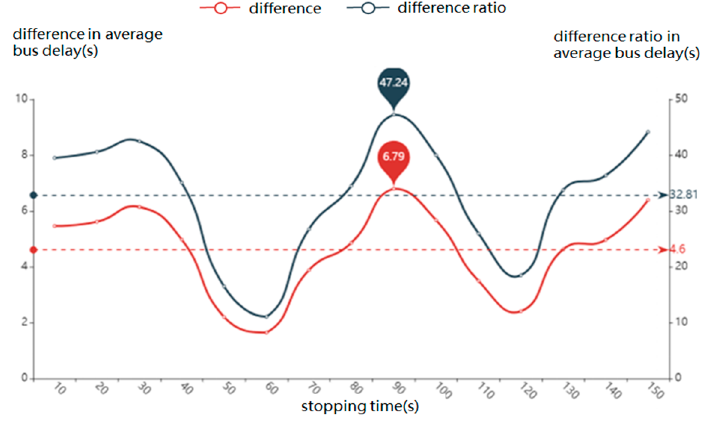
Figure 10. Change in average delay for each stopping time in the downstream direction.